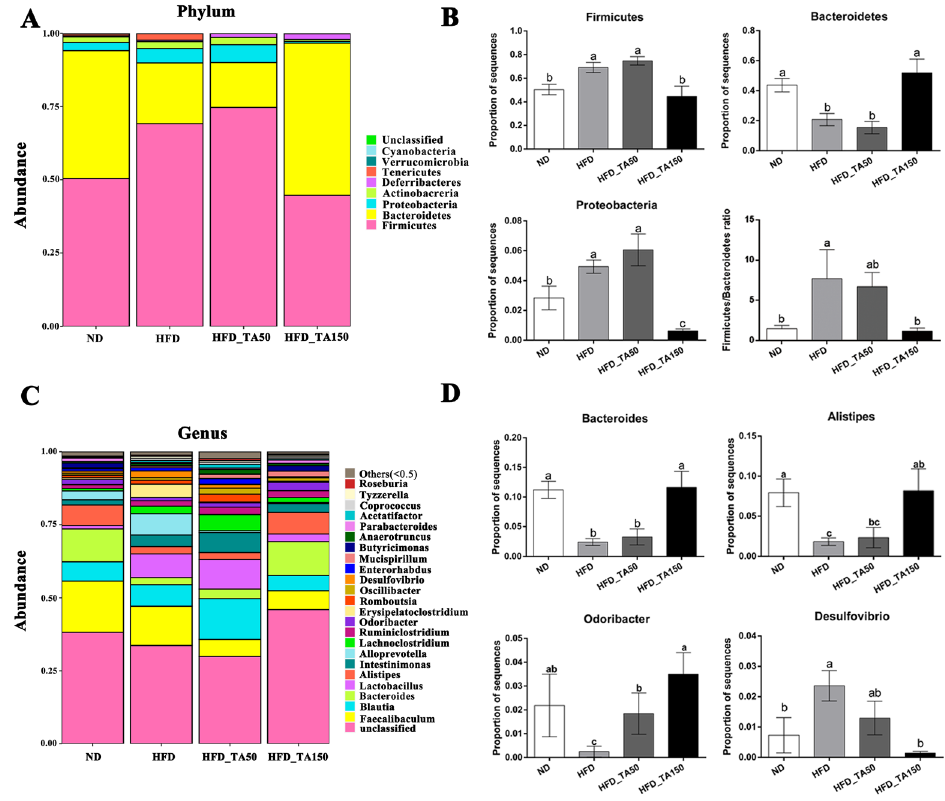
Figure 6. Effect of dietary tannic acid on the composition of gut microbiota at the phylum and genus level. ( A ) Taxonomic distribution at the phylum level, ( B ) relative abundance of Firmicutes, Bacteroidetes, Proteobacteria, and Firmicutes/Bacteroidetes ratio, ( C ) taxonomic distribution at the genus level, ( D ) relative abundance of Bacteroides , Alistipes , Odoribacter and Desulfovibrio . Data are expressed as mean ± SEM. Different letters between any two groups indicated that there was significant difference between the two groups ( p < 0.05).